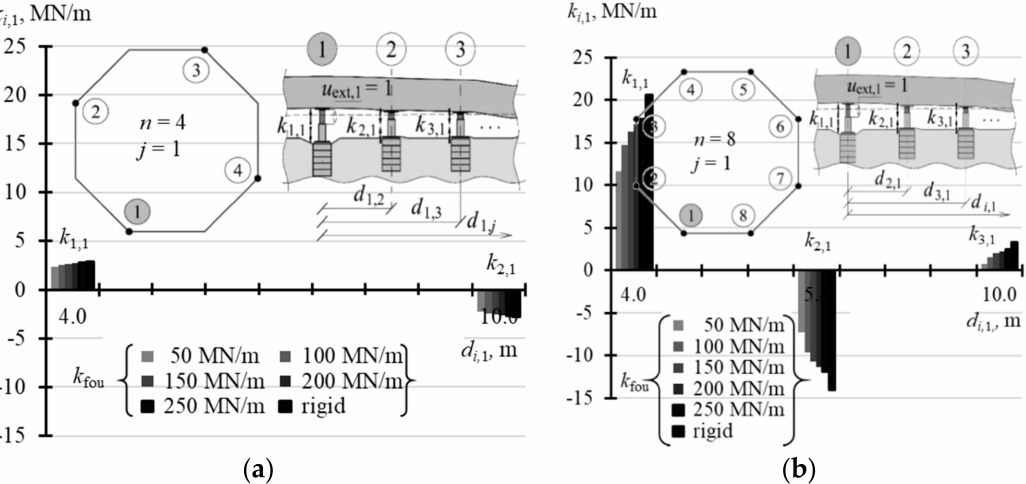
Figure 15. Selected elements of the stiffness matrix k for the structure for different stiffness values k fou of the jack supports for: ( a ) n = 4; ( b ) n = 8.